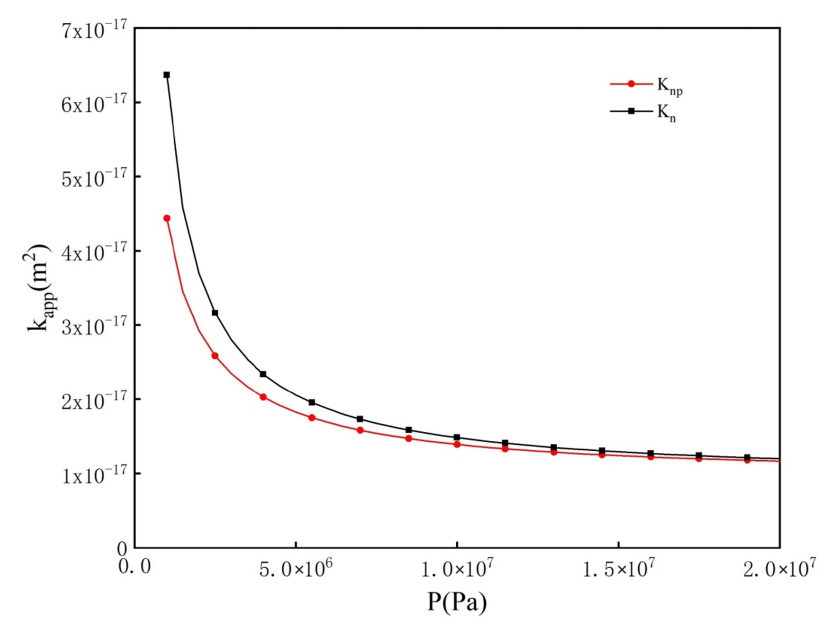
Figure 3. Apparent permeability vs. pressure with K n